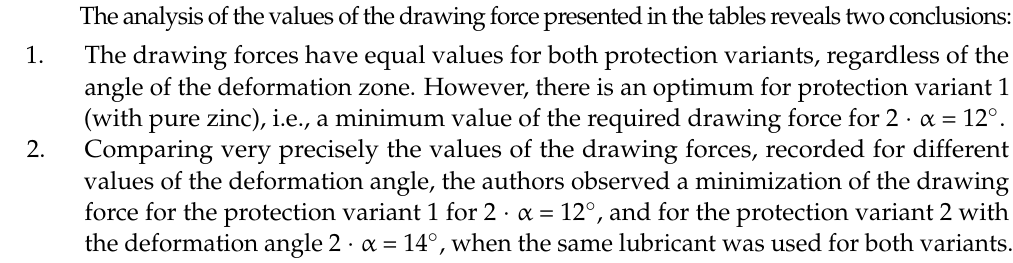
Figure 14. The drawing force of protection variants 1 and 2 for a deformation angle 2· α = 16°.